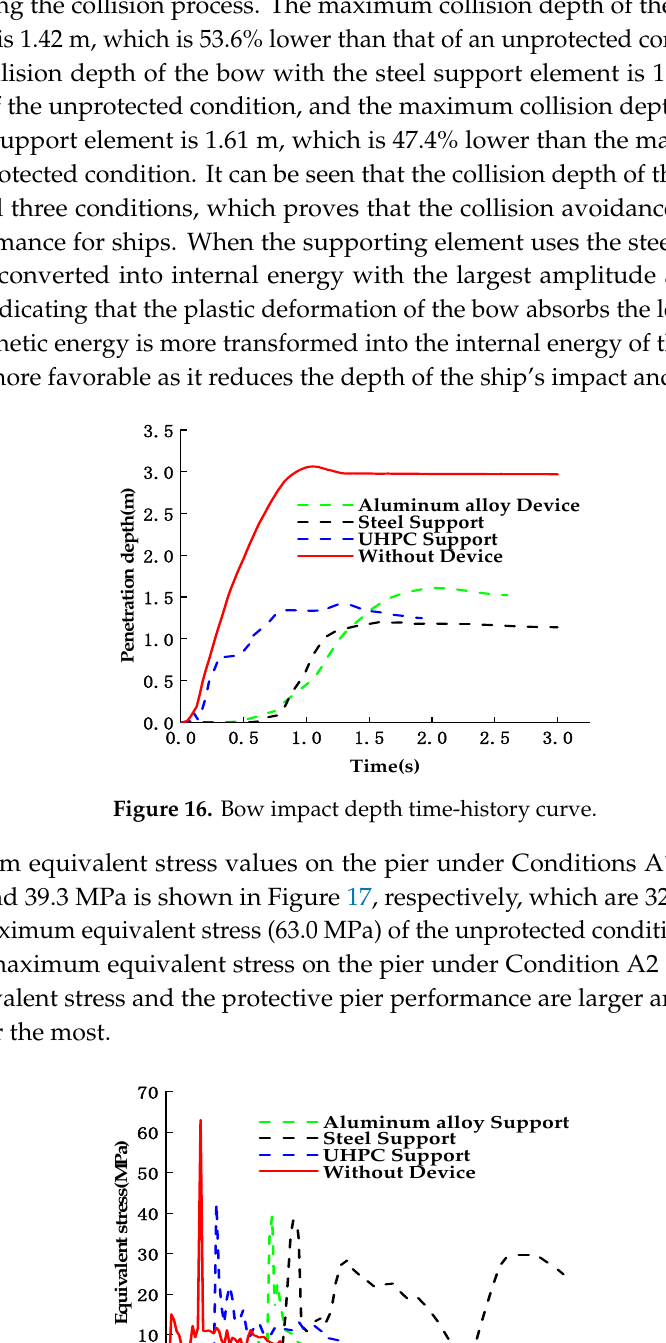
Figure14. Energy diagram of the steel supporting.